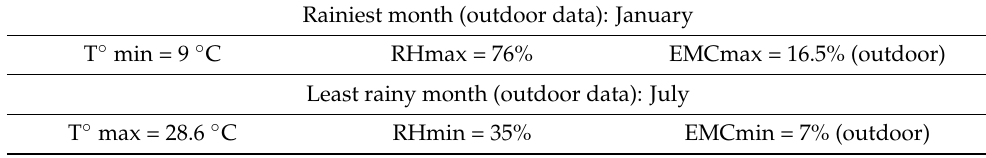
Table 1. Data of the maximum and minimum hygrothermal condition of Ecija at outdoor [64], and the corresponding theoretical timber